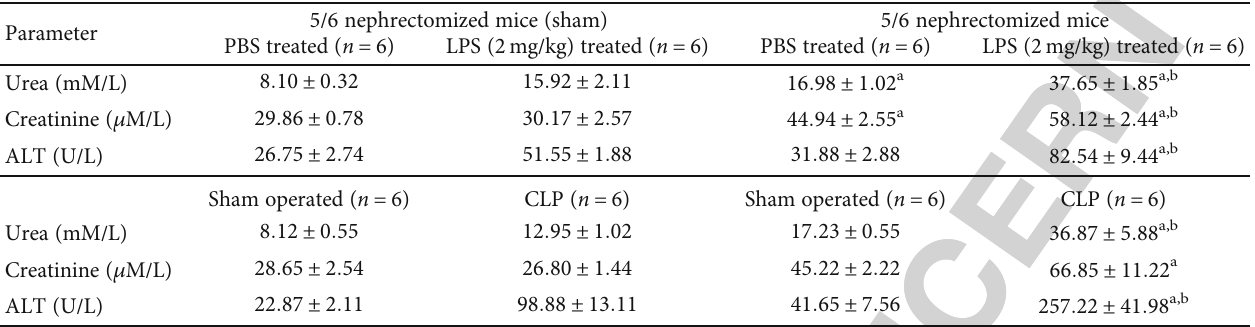
Table 2: E ff ects of LPS treatment or CLP on hepatic injury and renal function in 5/6 nephrectomized mice. Parameter